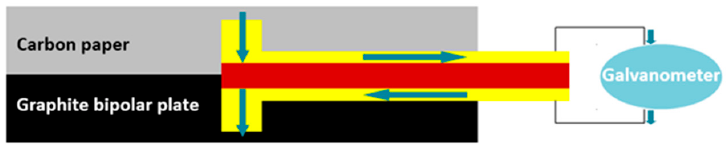
Figure 3. Schematic diagram of the principle of the micro current sensor.